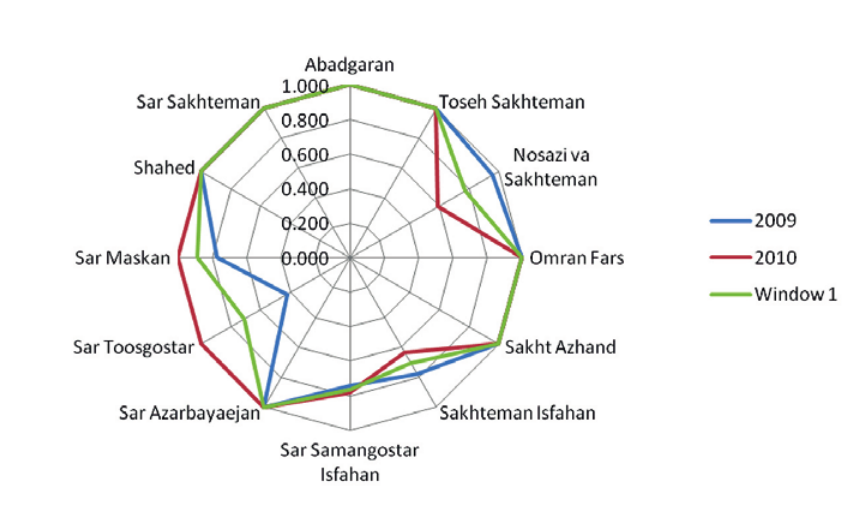
Figure 4. Stability of relative efficiency scores using Window